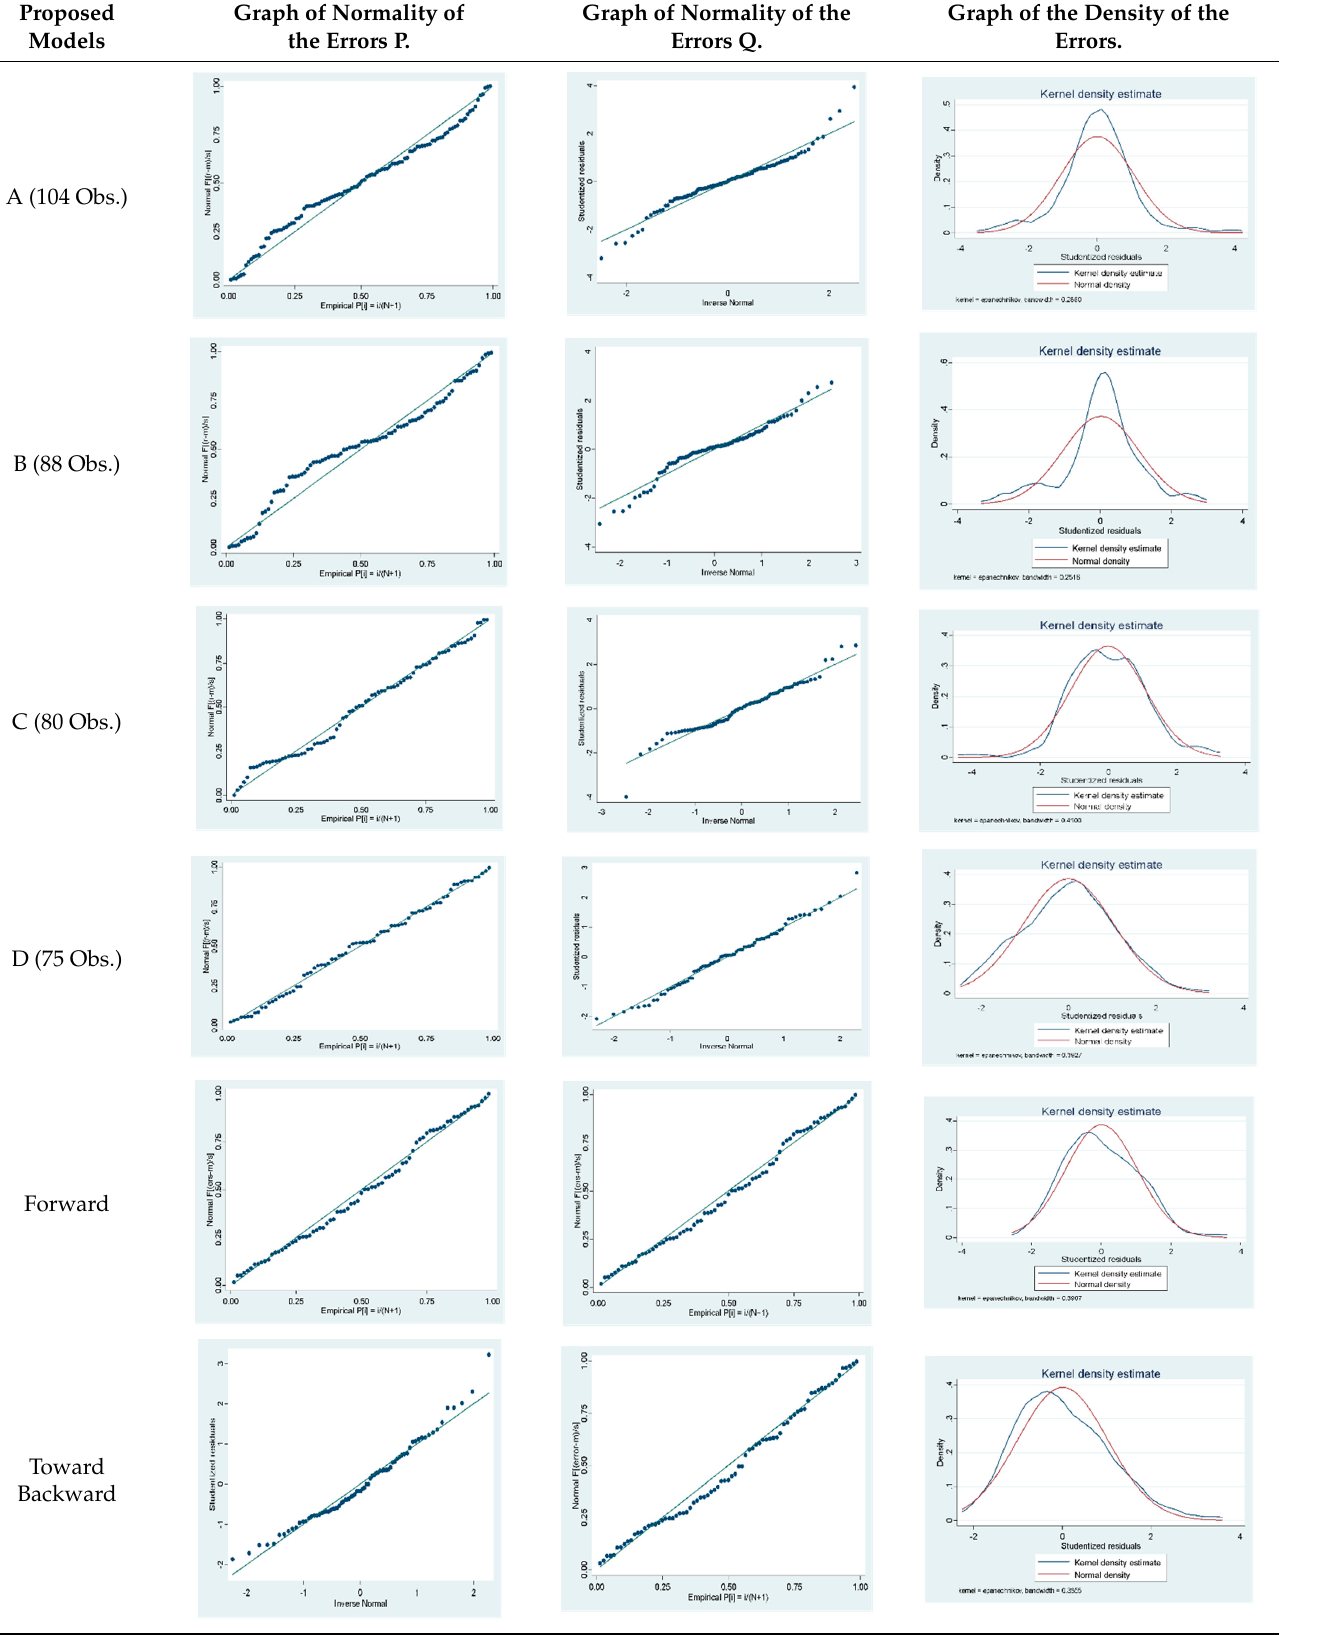
Table 11. Comparative summary of the different models proposed based on the normality conditions in the residuals. Proposed Models Graph of Normality of the Errors P. Graph of Normality of the Errors Q. Graph of the Density of the Errors. A (104 Obs.)